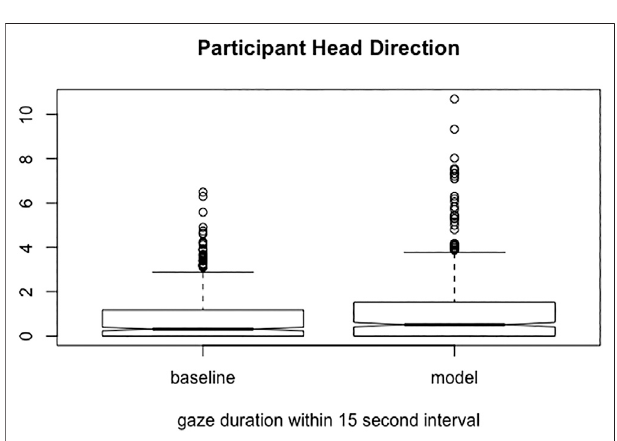
FIGURE 8 | Percentage of time spent gazing towards the attentive listener system robot (model) vs. the baseline system robot (baseline).